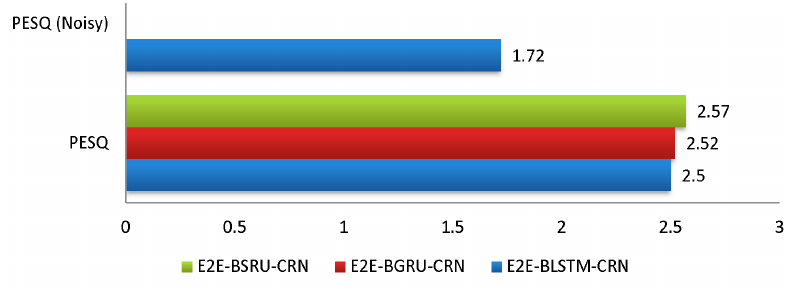
Figure 6. Average STOI Scores (Seen Noisy Environments).